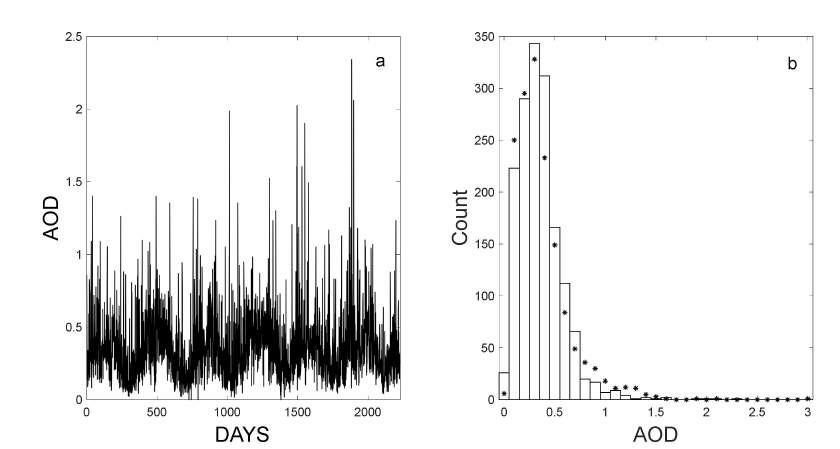
Figure 1. ( a ) An example of the gap-filled data and ( b ) the relative distribution, which the log-normal distribution is superposed to (black stars). A strong periodicity is visible in the waveform.